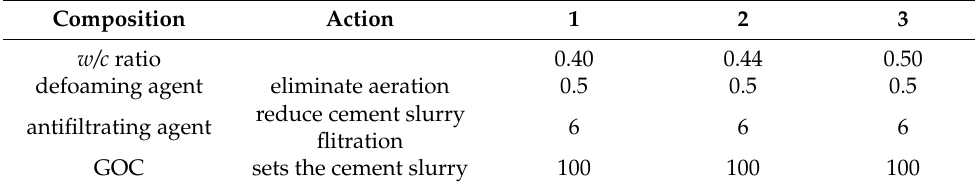
Table 2. Selected compositions of cement slurries.